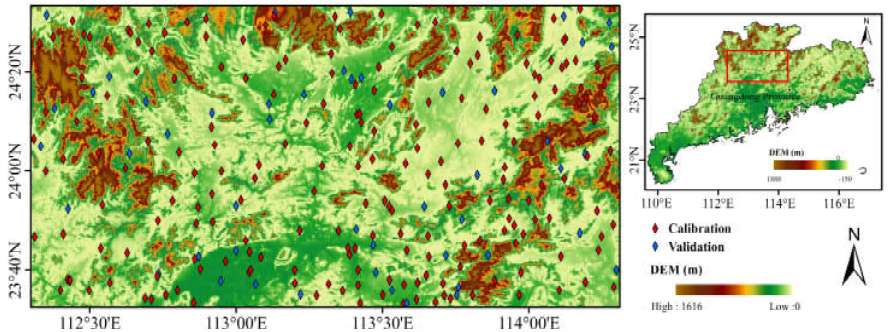
Figure 1. Study area and the distribution of the meteorological